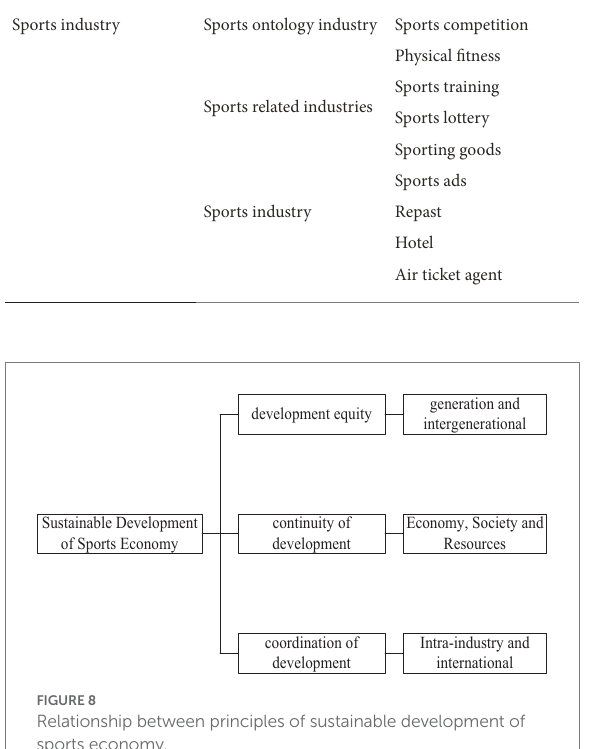
TABLE 3 Variable descriptive